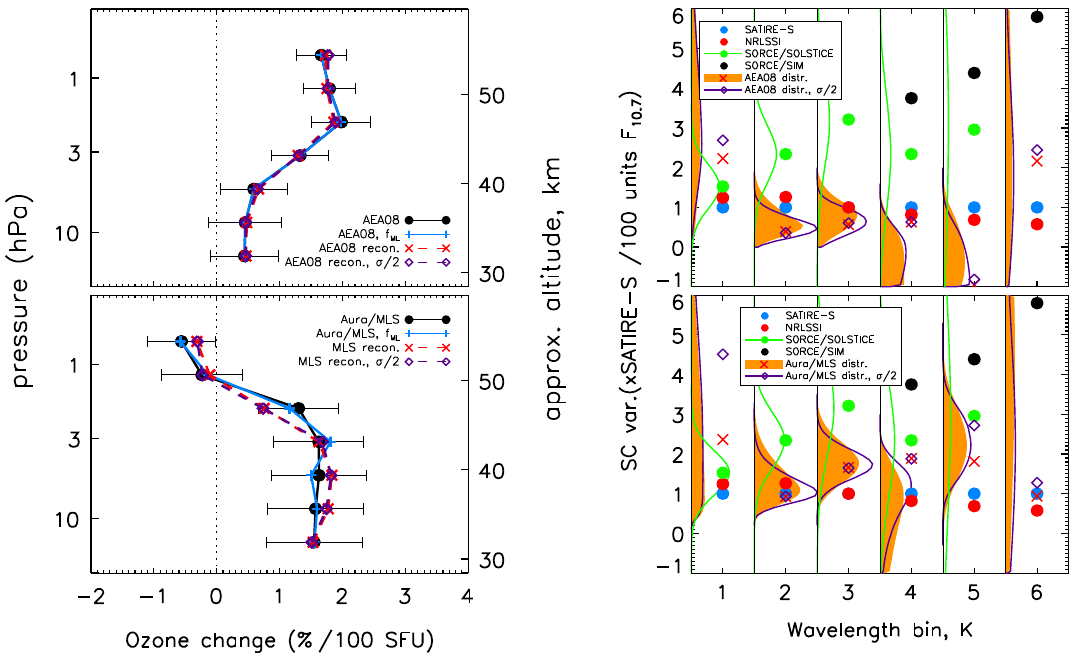
Fig. 3. The (left) D O 3 ( z ) profile and the (right) respective SC SSI change in multiples of SATIRE-S for the six wavelength bands for (top) AEA08 and (bottom) Aura/MLS. The relative variability of SATIRE-S (blue), NRLSSI (red), SORCE/SOLSTICE (green) and SORCE/SIM (black) is represented by the filled circles. The green distribution is the uncertainty on the SORCE/SOLSTICE data. Posterior distributions are shown for the sampled SC changes using original (orange, filled) and halved (purple line) error bars. Red (crosses) and purple (diamonds) D O 3 ( z ) profiles are the linear model profiles from the best-fit sampled parameters (also crosses and diamonds in the right-hand plots) with priors employed for the original and halved errors; the values of these individual, best-fit models are listed in columns 4 and 6 of Table 4. Table 4. SC flux changes within the six wavelength bands per 100 SFU given in terms of multiples of SATIRE-S. The maximum likelihood SSI SC changes without priors of Aura/MLS and AEA08 are given in columns 3 and 5, respectively. The maximum likelihood SC SSI changes with priors inferred for the Aura/MLS and AEA08 D O 3 ( z ) profiles are given in columns 4 and 6, respectively; the inferred changes for halved errors on the D O 3 ( z ) profiles are given in